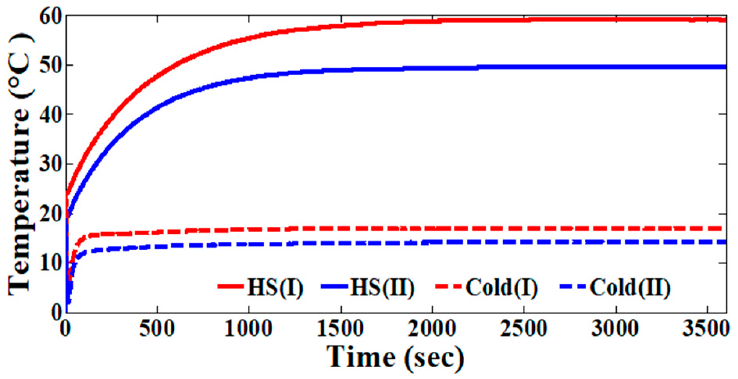
Figure 27. Type II heat-source temperature.